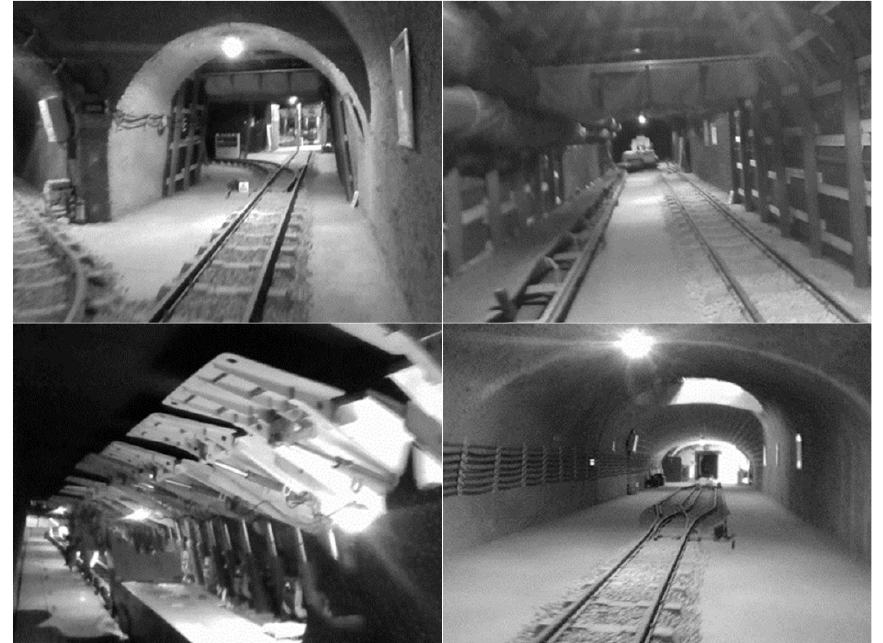
Figure 13. Scenes from coal mine tunnel.